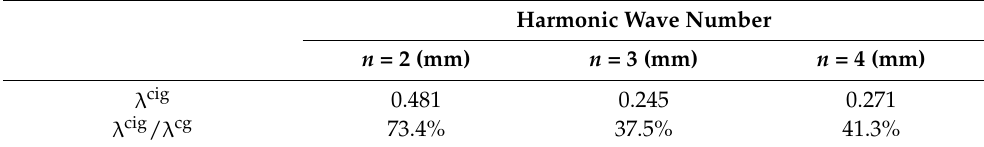
Figure 13. Nonlinear equilibrium paths for the 100,000 m 3 steel tank with HSII.